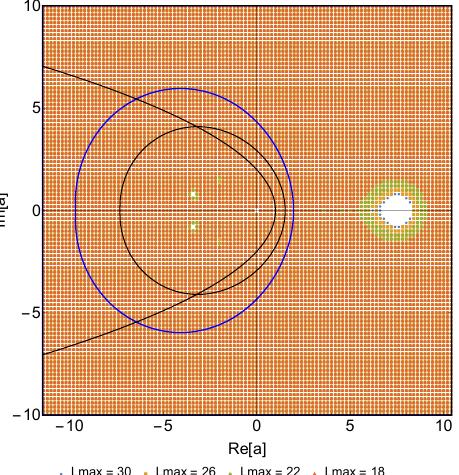
(a) For fixed a = 11 + 9 i , we compare the (b) The analyticity domain in complex a -plane 10 10 exact amplitude and the Dyson and Feyn- for various s 1 in the range δ 0 < s 1 < ∞ . We man block expansion as a function of s 1 with consider s 1 = 23 / 3 for various examples is shown k max = 30 , L max = 30 . Blue curve is exact, in red contour. Other two curves dictate the green is Dyson and red dashed is Feynman boundary of the overall domain. block expansion.